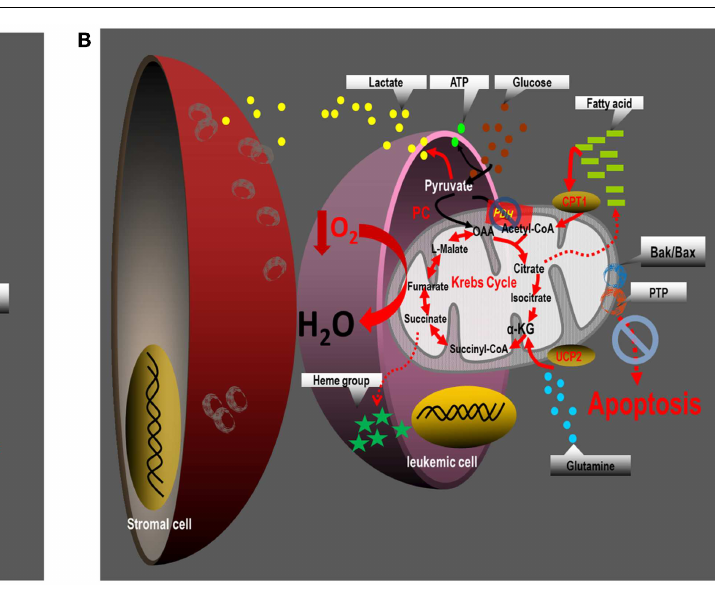
Under coculture conditions leukemia cells augment aerobic glycolysis and increase Krebs cycle activity in a manner dependent on anaplerotic reactions – in particular glutaminolysis, and to a lesser extent pyruvate carboxylation.The increased Krebs cycle activity does not oxidize pyruvate-derived acetyl-CoA, but instead metabolizes large quantities of fatty acid-derived acetyl-CoA to sustain increased rates of oxygen consumption, that may contribute to the generation of local hypoxic conditions. Mitochondrial uncoupling in leukemia cells is associated with increased expression of UCP-2, and increased resistance to apoptotic stimuli that induce Bax/Bak-dependent